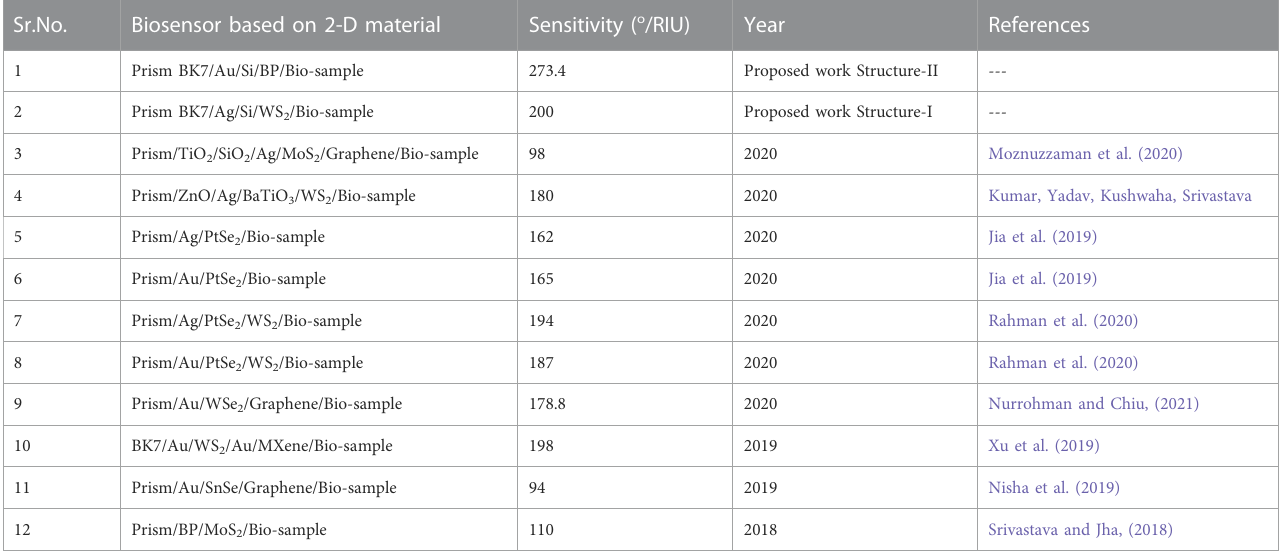
TABLE 8 Comparison of Proposed work with some of the recently published work.